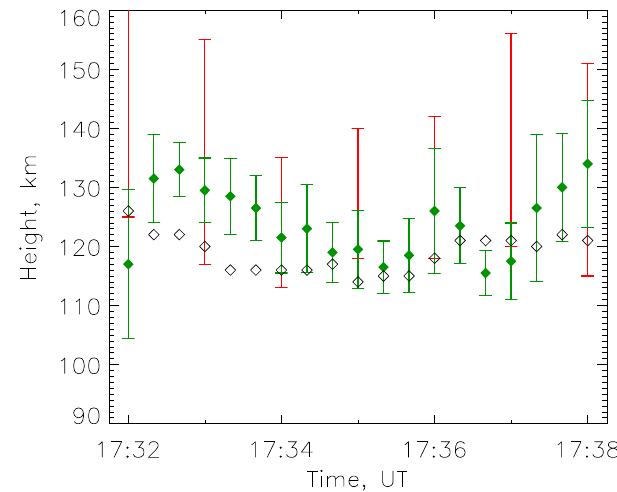
Fig. 16. The peak emission height of an auroral arc on 22 November 2000 found using method 1 (black), method 2 (green) and by the manual method of Sangalli et al. (2011) (red). In all cases the Abisko and Kilpisj¨arvi stations were used.